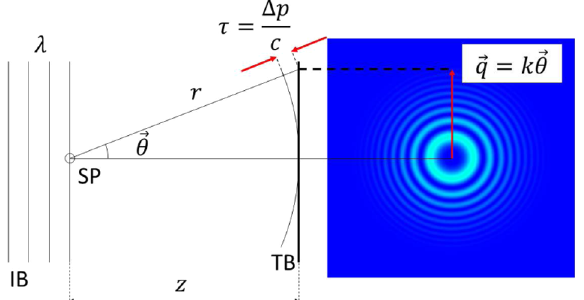
FIG. 6. Geometry relating Fourier wave vectors ⃗ q to the temporal delays τ associated to the optical path difference Δ p . As explained in the text, only q ¼ j ⃗ q j is relevant, due to circular symmetry in power spectra dominated by temporal coherence. IB represents the incoming beam of wavelength λ , SP the scattering particle and TB the transmitted